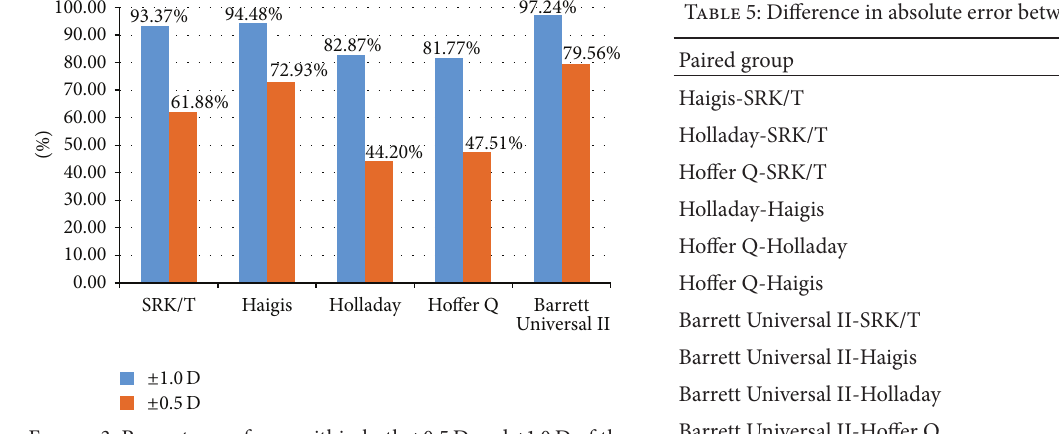
Figure 3: Percentages of eyes within both ± 0.5D and ± 1.0D of the target refraction.